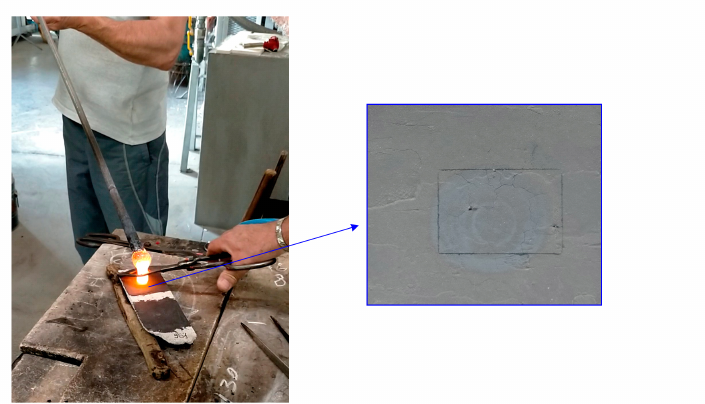
Figure 9. Melt deposition on the surface of the sample in the traditional hand-made process of art glass production. On the right, the spot caused by the melt-mold